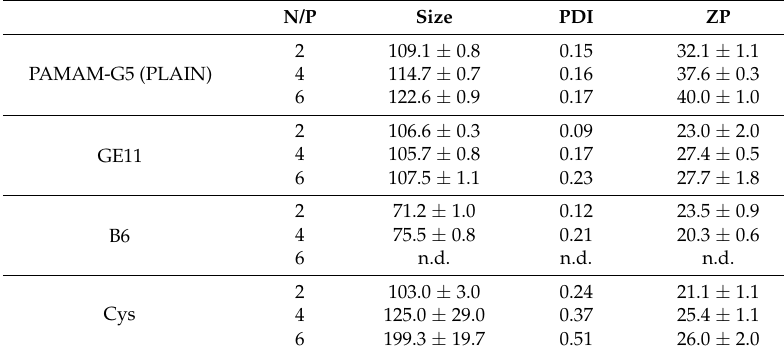
Table 1. Particle size and surface charge in the presence or absence of ligands and different N/P ratios. The data are represented as the mean ± SD (standard deviation) of three measurements.